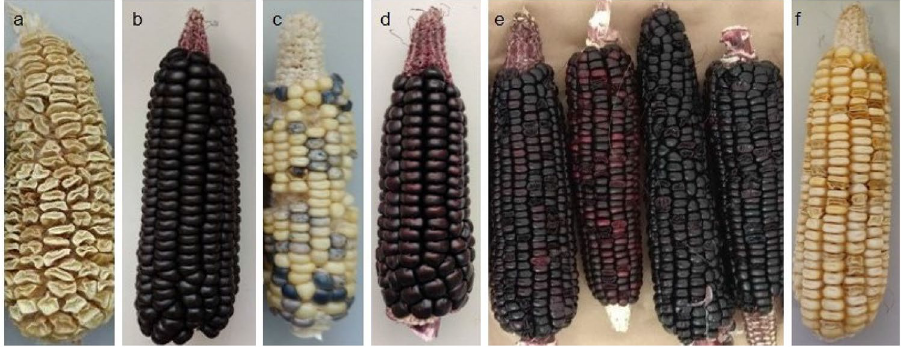
Figure 1. Parents and F1 progenies: (a) white sweetcorn parent (‘Tims-white’-derived accession); ( b) purple maize parent (‘Costa Rica’); ( c) F1 round kernels with white-pericarp, with or without blue-aleurone; ( d) reciprocal cross showing F1 round kernels with purple-pericarp. F2 progenies: (e) cobs with purple-pericarp and reddish-purple-pericarp kernels with a 3:1 ratio of round to shrunken kernels; ( f) white cob with a 3:1 ratio of round to shrunken